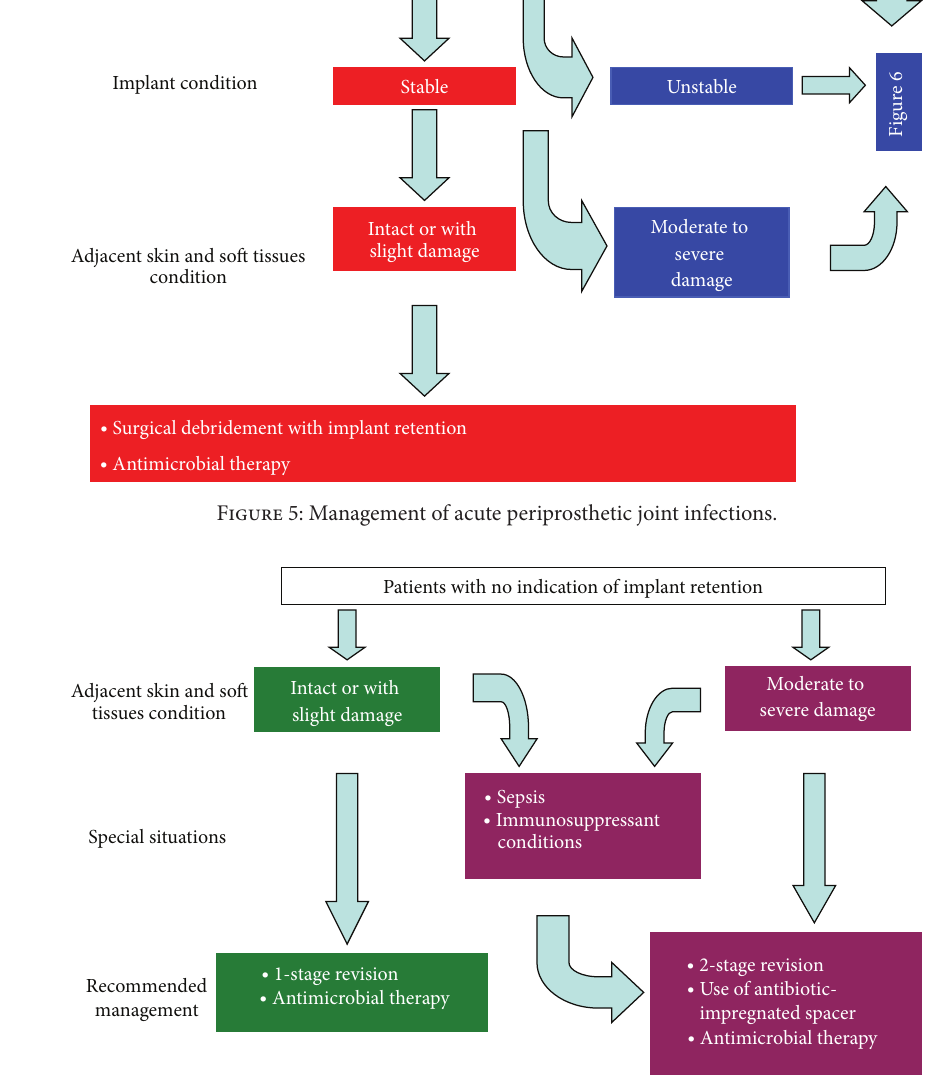
Figure 6: Management of periprosthetic joint infections with indication for implant